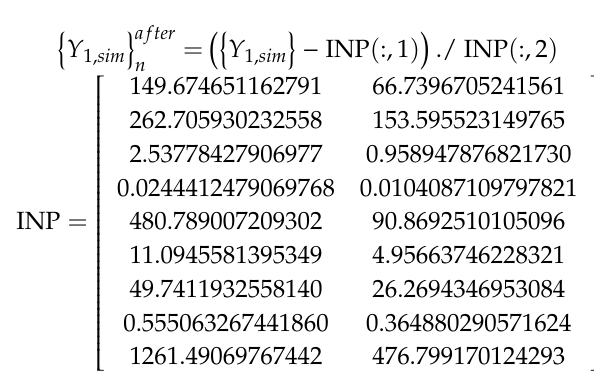
Figure 4. Proposed 9-12-12-12-1 fully connected MLPN—simplified scheme.